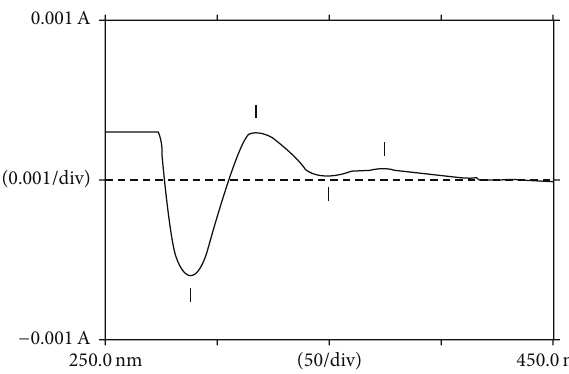
Figure 4: Second derivative spectrum of colistin solution (318nm, 2400